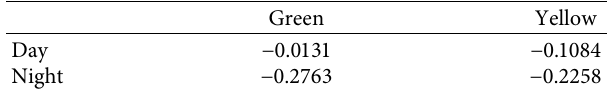
Table 6: Marginal effects of colors of green and yellow on accident likelihood at night and